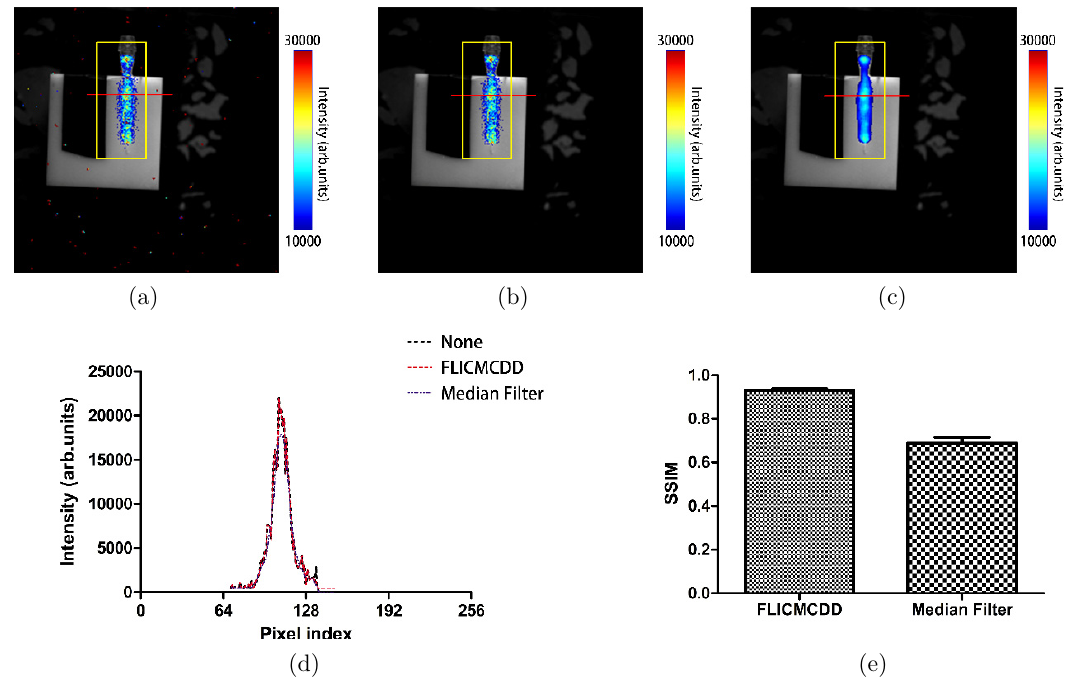
Fig. 4. Result of physical phantom experiment: (a) original CLI image; (b) denoised CLI image by using FLICMCDD; (c) denoised CLI image by using median ¯lter; (d) quantitative line pro¯le (red line in (a), (b) and (c), respectively) and (e) comparison of SSIM (yellow rectangle) for FLICMCDD and median